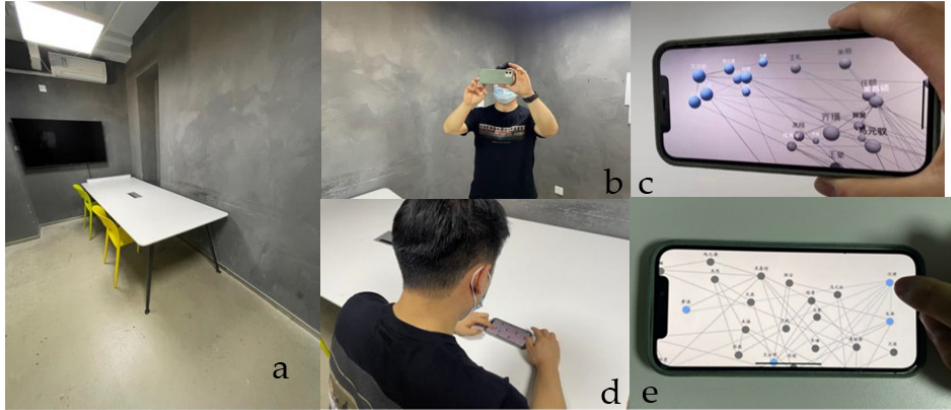
Figure 3. Experiment settings: ( a ). laboratory room; ( b ). the user experiences the AR graph; ( c ). AR graph; ( d ). the user experiences the 2D graph; ( e ). 2D graph (the text on top of the nodes are the Chinese names of the painters).